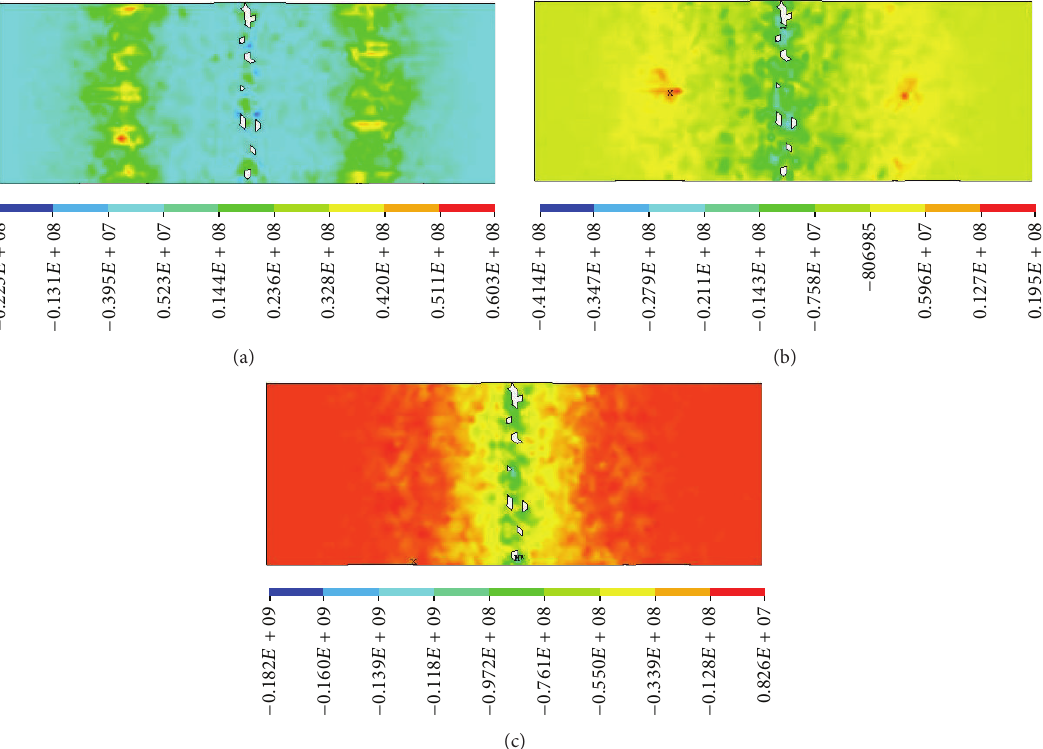
Figure 6: Top skin stress distribution: (a) 1st principal stress; (b) 2nd principal stress; (c) 3rd principal stress.